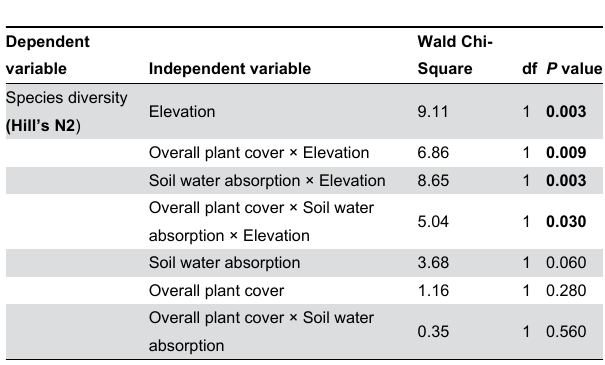
Table 4. Relative importance of habitat variables and their interactions (×) to species diversity according to GLM (generalized linear model) analyses.